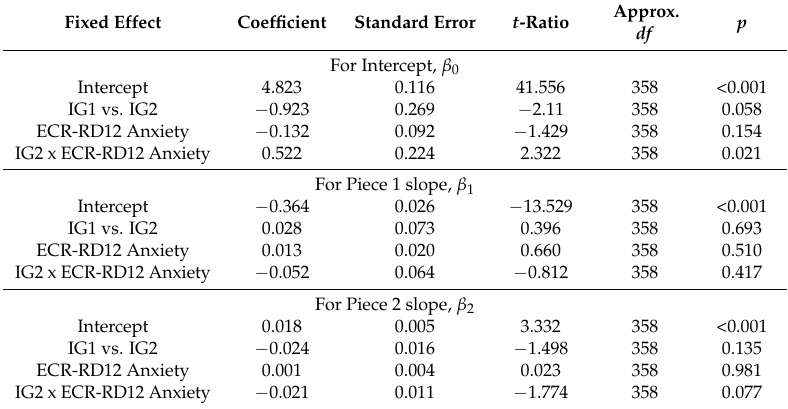
Figure 4. Effect of attachment on average pain across treatment groups. Table 4. Results of multilevel model with average pain intensity as outcome, n = 374 .